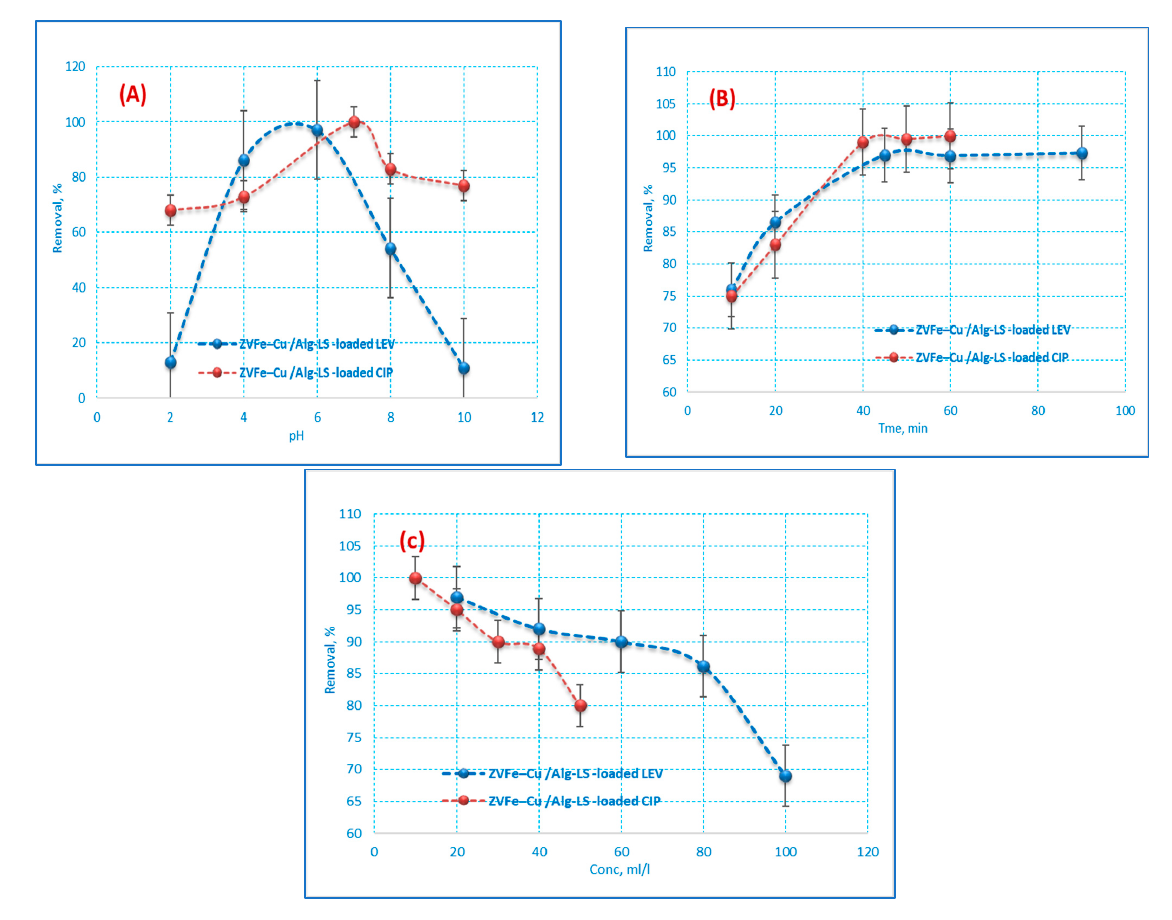
Figure 6. Influences of ( A ) pH, ( B ) contact time and ( C ) initial (CIP and LEV) concentration on the adsorption of CIP and LEV by 0.2 g/25 mL of the nanocomposite at pH 6 (CIP) 7 (LEV) and a contact time of (40 min (CIP) 45 min